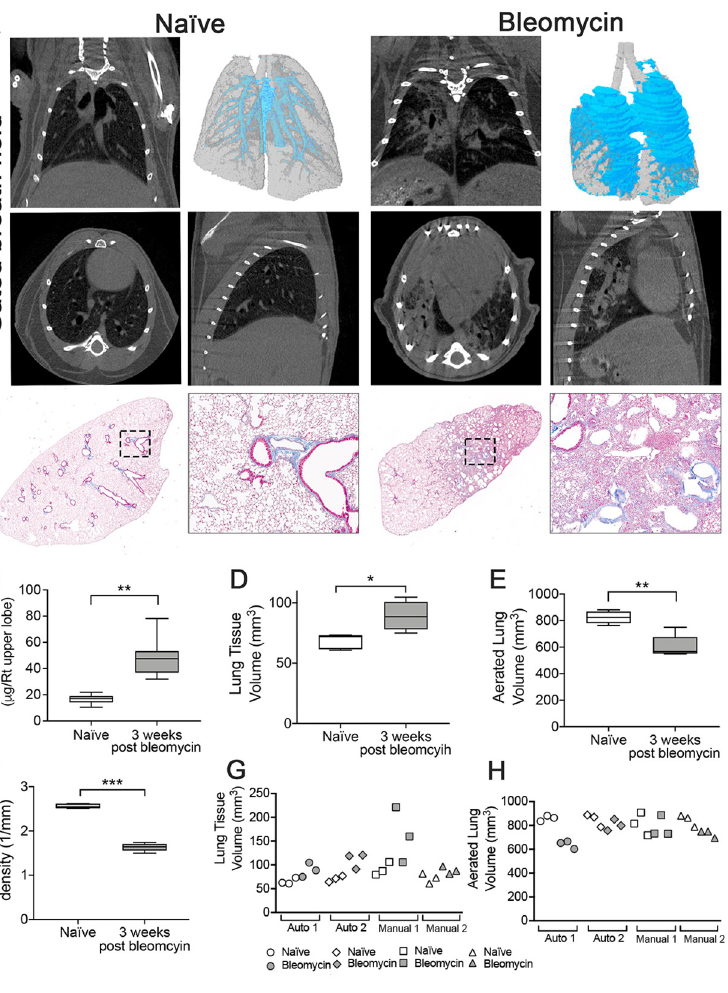
Fig 1. Respiration-gated imaging in bleomycin induced fibrosis. (A) microCT images from a respiration-gated scan of a saline and a bleomycin-instilled mouse 3 weeks post-instillation imaged on a Bruker Skyscan 1276 at 35 μ m resolution. Representative images of coronal (top left), transverse (bottom left), and sagittal (bottom right) slices and a 3D surface rendering of aerated (gray) and tissue (blue) volume overlay (top right) are shown. (B) Representative images of lung tissue sections stained with Masson’s Trichrome (Magnification 2X (left) and 20X (right). (C) Hydroxyproline content in lungs. PATS task list quantification of (D) lung tissue volume (E) aerated lung volume and (F) structure linear density. Scatterplots of comparing (G) lung tissue volumes and (H) aerated lung volumes calculated from automated ROI generation (Auto 1 = CTAn (Bruker) and Auto 2 = Amira-Avizo (ThermoFisher) compared ROIs generated manually by two individuals. Open symbols = na ï ve lung values. Closed symbols = bleomycin lung values. n = 5 mice/group. Graphed as box and whisker plot (min, max with mean). � p < 0 . 05 , �� p < 0 . 01 , ��� p < 0 . 001 , 2-tailed t-test with Welch’s